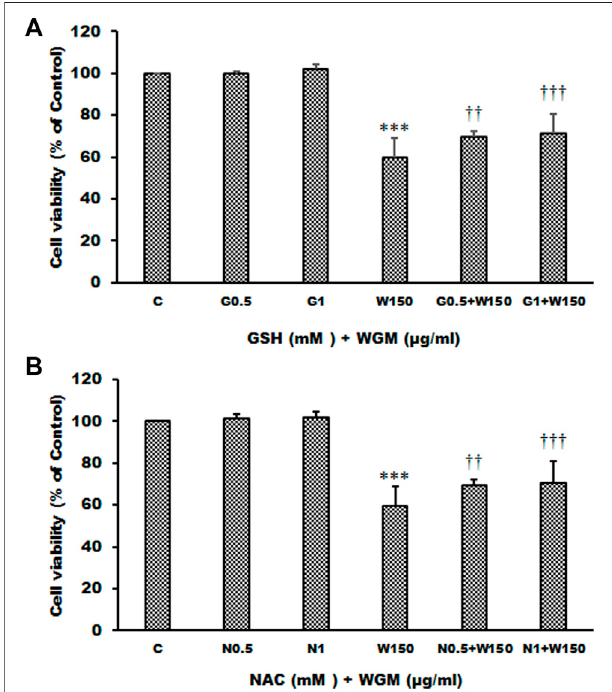
FIGURE7| EffectsofGSHorNAConWGMextracts-inducedcelldeath ofHep3Bcells. (A) Cellswerepretreatedwith0.5or1 mMGSH(G0.5andG1) for 1 h and then 150 μ g/ml WGM extracts (W150) for 24 h. (B) Cells were pretreatedwith0.5or1 mMNAC(N0.5andN1)for1 handthen150 μ g/ mlWGM extracts(W150)for24 h. Themedium wasnot changed inthewhole process of the experiment. After treatment, the viable cells were measured by MTT assay. Data represent the mean percentage of control ±S.D. ( n = 4). *** p < 0.001 compared to the control values. †† p < 0.01, ††† p < 0.001 compared to the WGM extracts